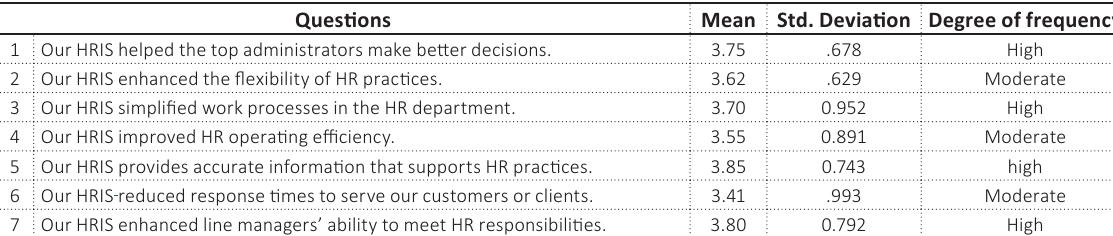
Table 2. Descriptive statistics for HRIS